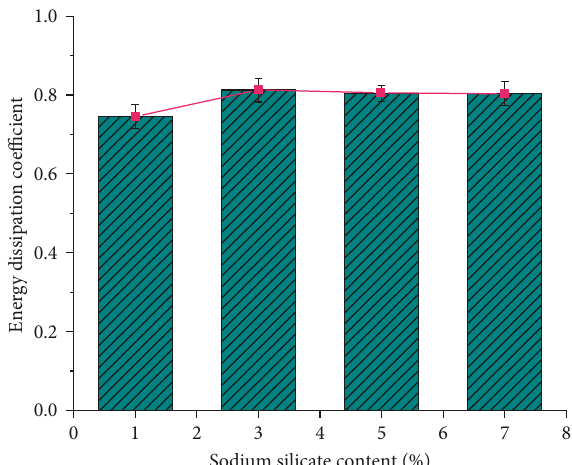
12: Energy dissipation of the lunar soil simulant under different contents of sodium